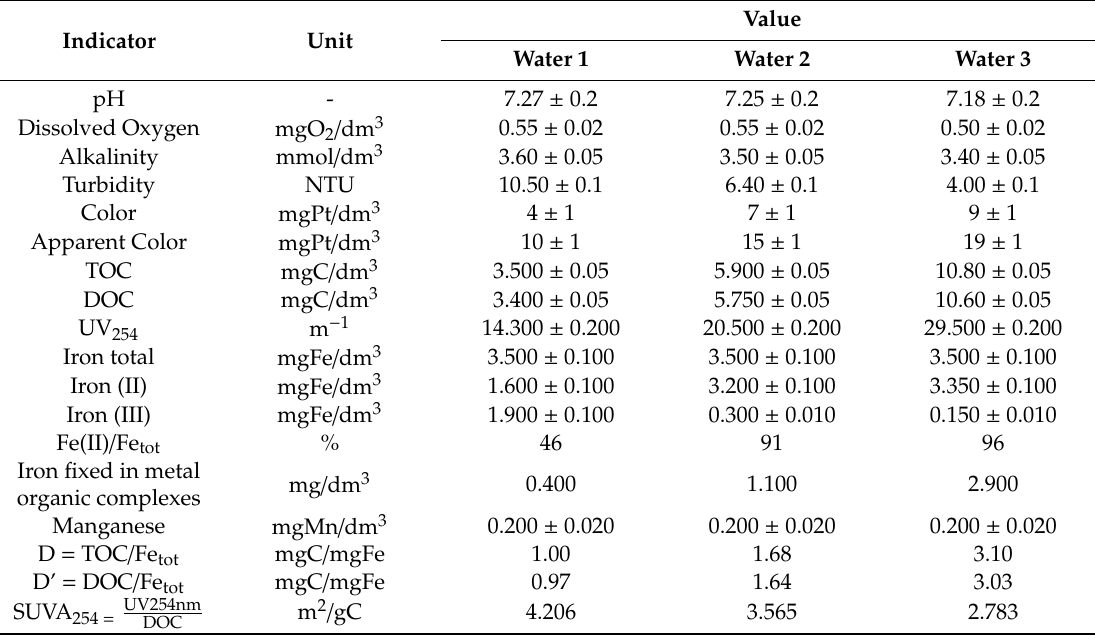
Table 3. Value ranges analyzed for the groundwater quality parameters.